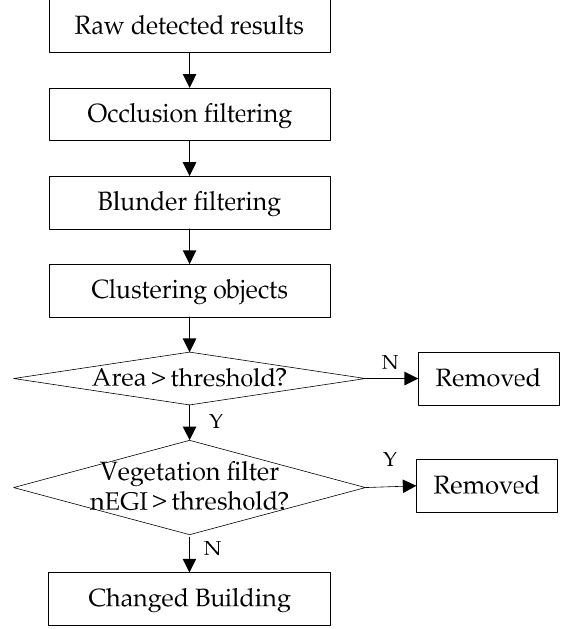
Figure 7. The workflow of negative building change refinement.